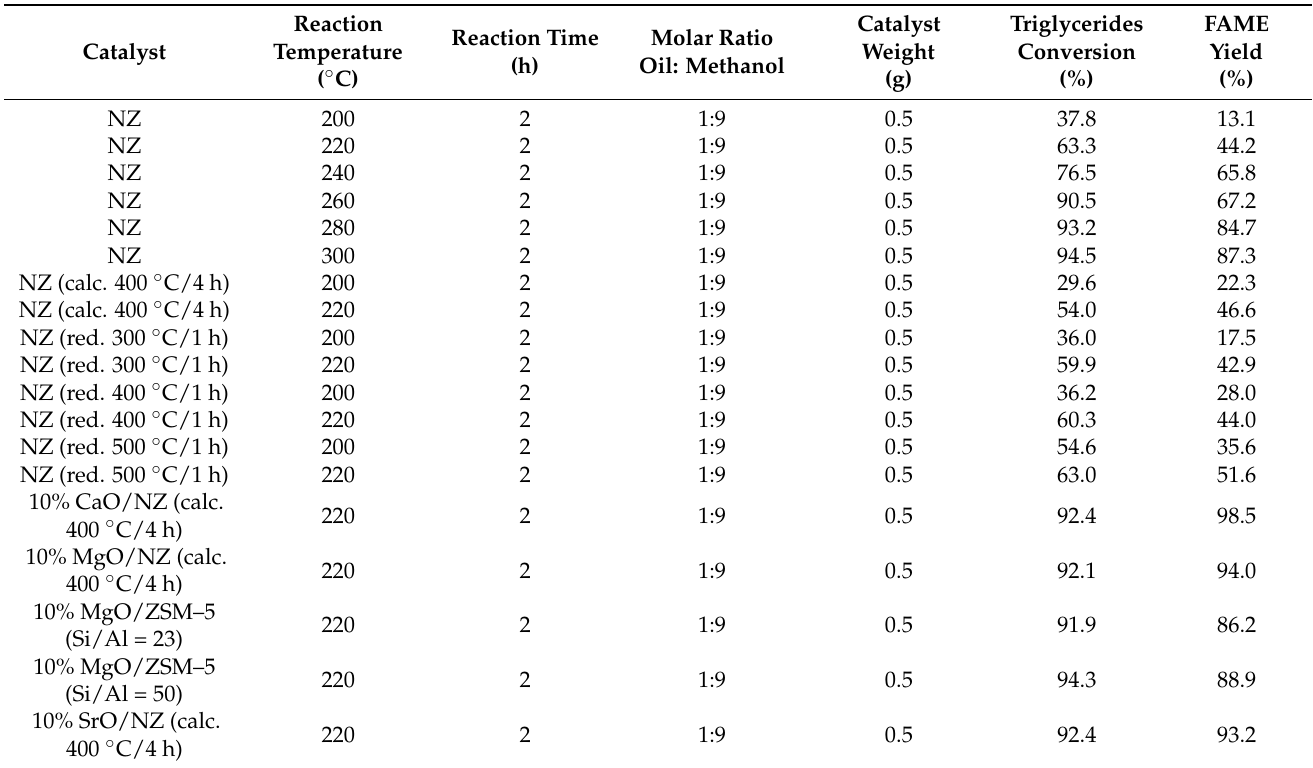
Table 2. The results of the transesterification process performed over pristine, treated NZ (reduced in a mixture of 5% H 2 –95% Ar, calcined in an air atmosphere at 400 ◦ C for 4 h) and metal-oxide